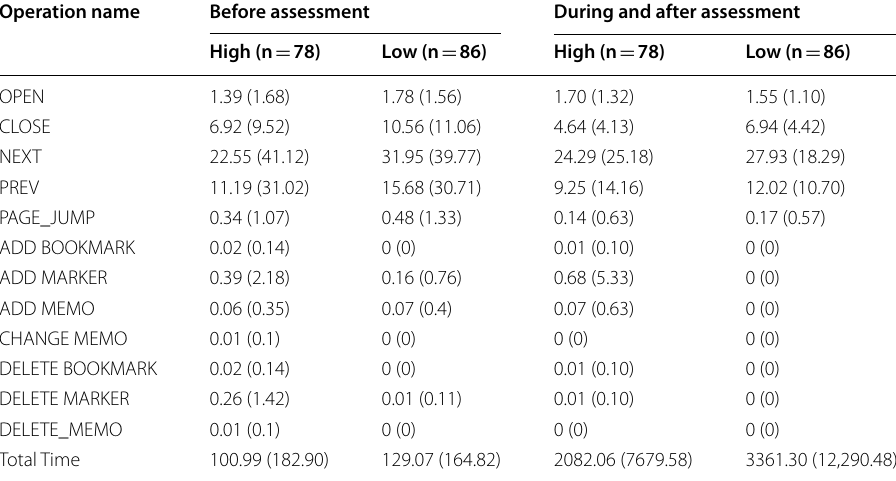
Table 3 Descriptive statistics of different operation types and total system usage time for high and low performance